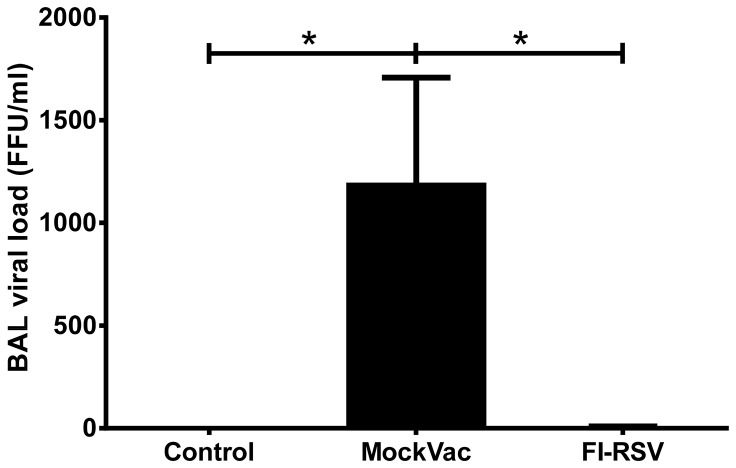
Bronchoalveolar lavage (BAL) titers of Control lambs (no vaccine and no RSV), mock-vaccinated (MockVac) lambs and FI-RSV-vaccinated lambs.FI-RSV-vaccinated lambs had significantly less RSV load compared to mock-vaccinated lambs. Control lambs lacked RSV titers. Control n = 4; MockVac n = 4; FI-RSV n = 4. Error bars = SEM, *P<0.05. FFU = focus-forming units per ml.